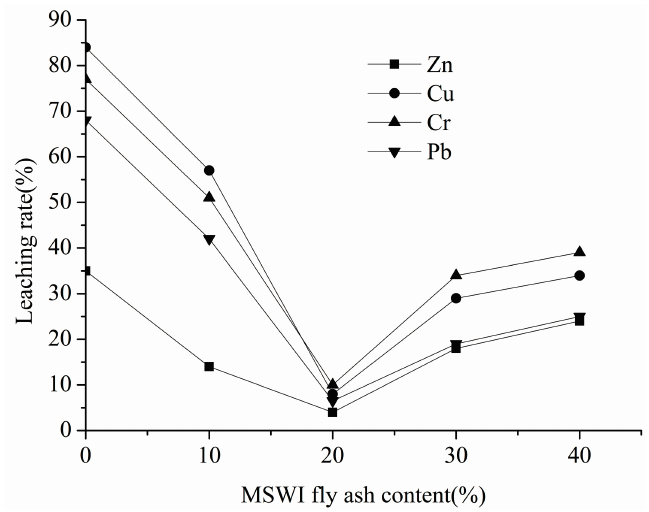
Figure 1. Leaching rate of Zn, Cu, Cr and Pb in LWA containing sludge with influence of MSWI fly ash